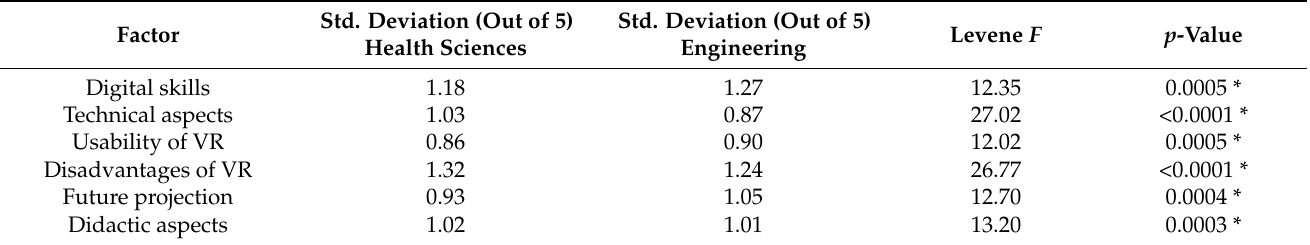
Table 3. Standard deviations and statistics of Levene’s test of variance comparison, differentiating by areas of knowledge.